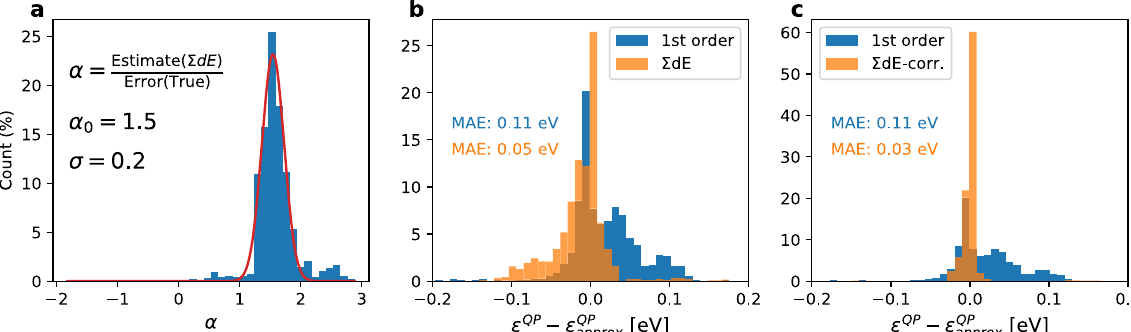
Fig. 7 Estimated errors and the Σ d E method. a The distribution of the ratio of the estimated error and the true error. Also shown in red is a gaussian fi t to the distribution. The text annotations are shown the de fi nition of α (top), the mean of the fi tted gaussian, α 0 (middle), and the standard deviation of the fi tted gaussian, σ , (bottom). b Distribution of the error of the linear approximation (blue) and the error of solution derived from the estimated error (orange). c Correcting for the mean of α yields improved solution estimates